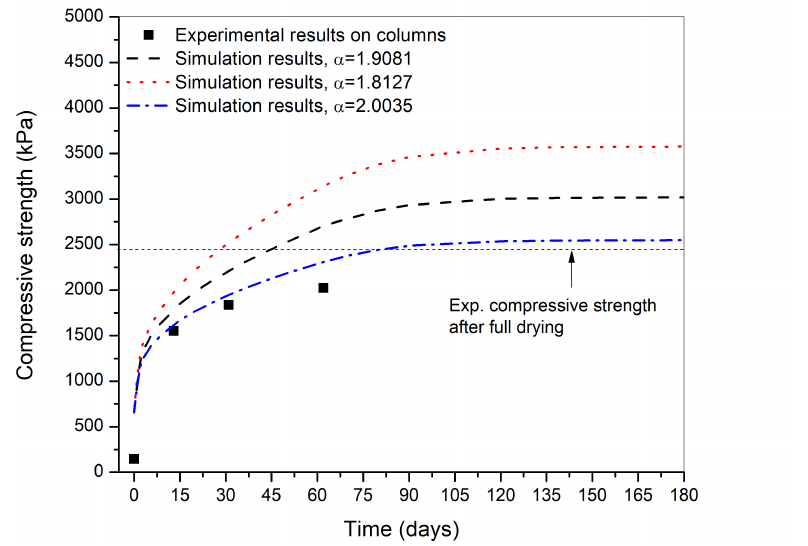
Figure 7. The variation of compressive strength with drying duration for the sensitivity analysis performed on the effective stress parameter χ .